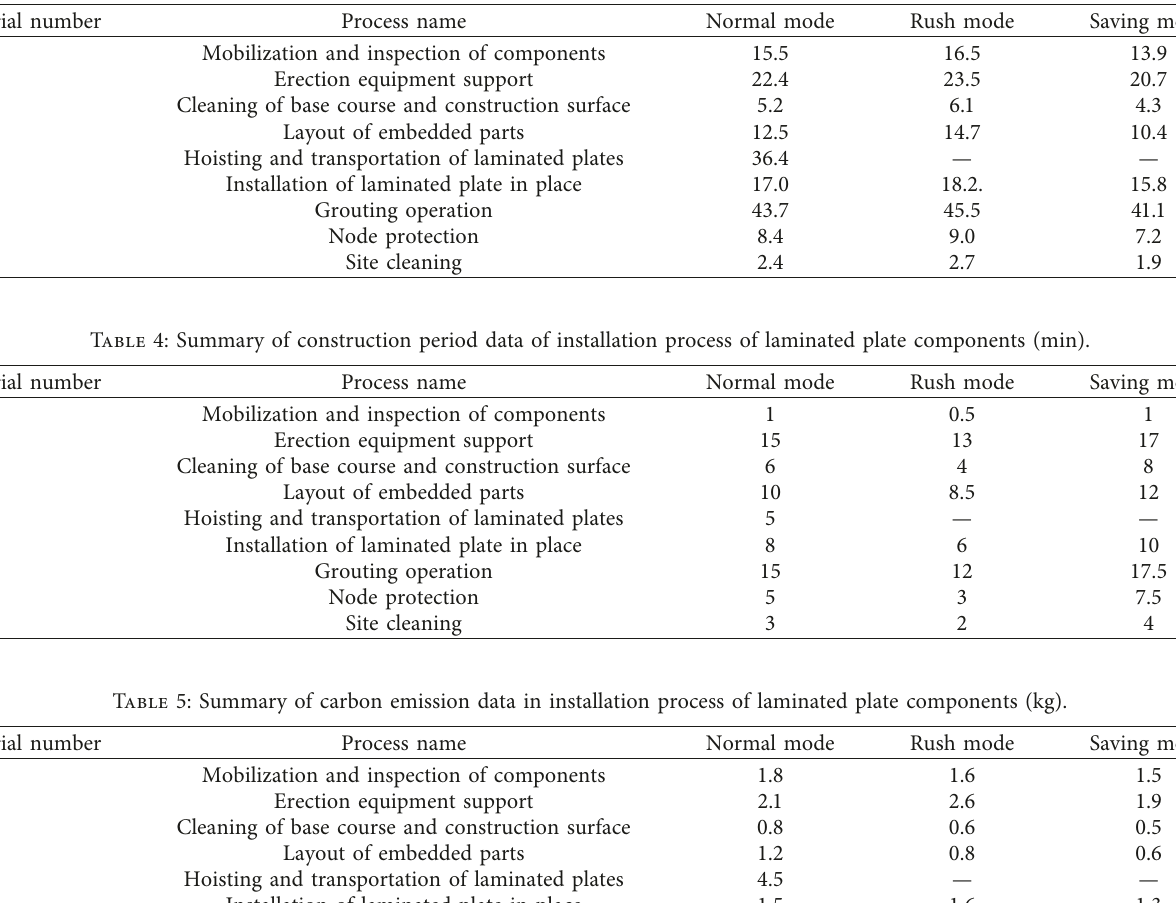
Table 3: Summary of cost data of installation process of laminated plate components